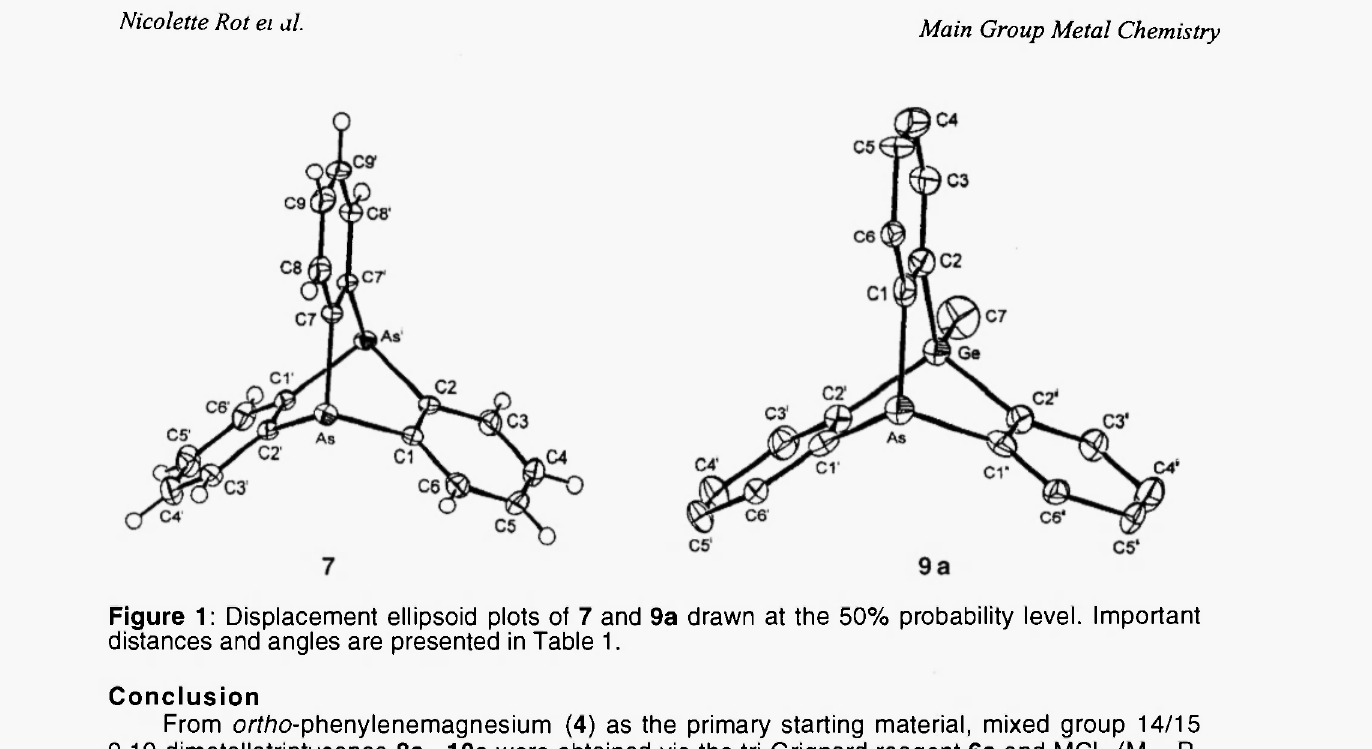
Figure 1: Displacement ellipsoid plots of 7 and 9a drawn at the 50% probability level. Important distances and angles are presented in Table 1.